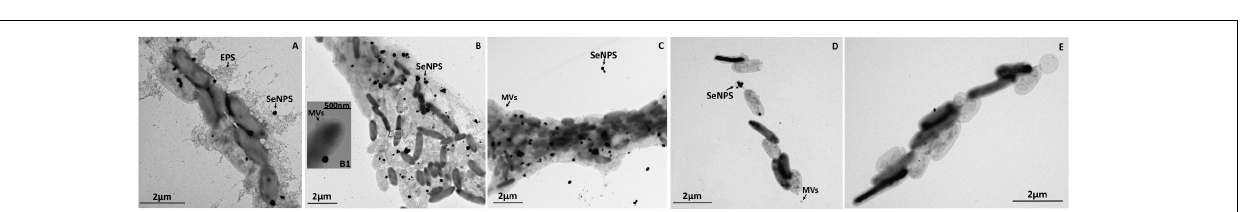
FIGURE 1 | Growth curves of Stenotrophomonas maltophilia SeITE02 (A,B) and Ochrobactrum sp. MPV1 (C,D) in DM amended with glucose and/or pyruvate (black curves), and with the addition of 0.5 mM SeO 2 − 3 (gray curves). The gray dashed curves represent the biotic conversion of SeO 2 − 3 over the timeframe considered.